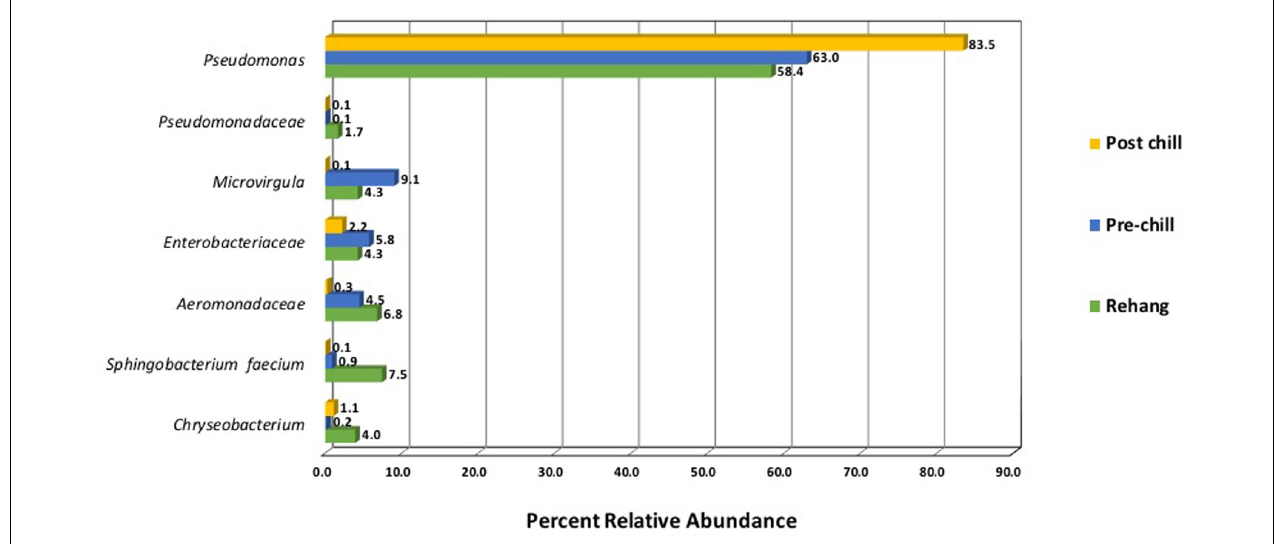
FIGURE 4 | Bio-map of microorganisms through evisceration when the genera were identified at all sampling locations and abattoirs.